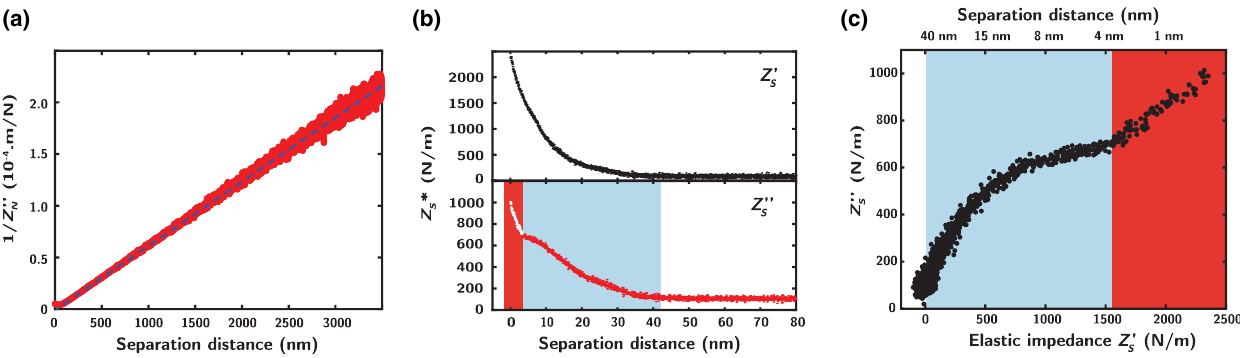
FIG. 2. Nanorheological and nanotribological measurements. (a) Inverse of the normal dissipative impedance 1 =Z 00 N as a function of separation between the surfaces. The dashed line results from a linear fit characteristic of viscous damping. The normal oscillation amplitude is a N ∼ 2 nm. (b) Evolution of the conservative Z 0 S (black) and dissipative Z 00 S (red) shear impedance as the separation distance is varied. A solidlike mechanical behavior of the nanoconfined RTILs is observed from ∼ 40 -nm confinement (blue zone) down to the direct metallic contact (red zone and white data points). The shear oscillation amplitude is a S ∼ 3 nm. (c) Corresponding shear dissipative impedance Z 00 S as a function of shear elastic impedance Z 0 S highlighting an abrupt change of frictional